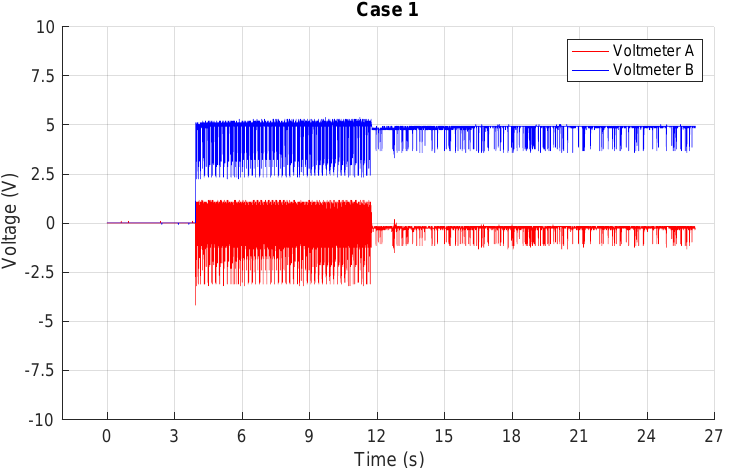
Figure 8. Case 1: Experimental results. During approximately 8 s (from approximately 4 s to 12 s), we filled the container with salty water, then stopped. The voltmeter detected this change of salinity with a small delay.